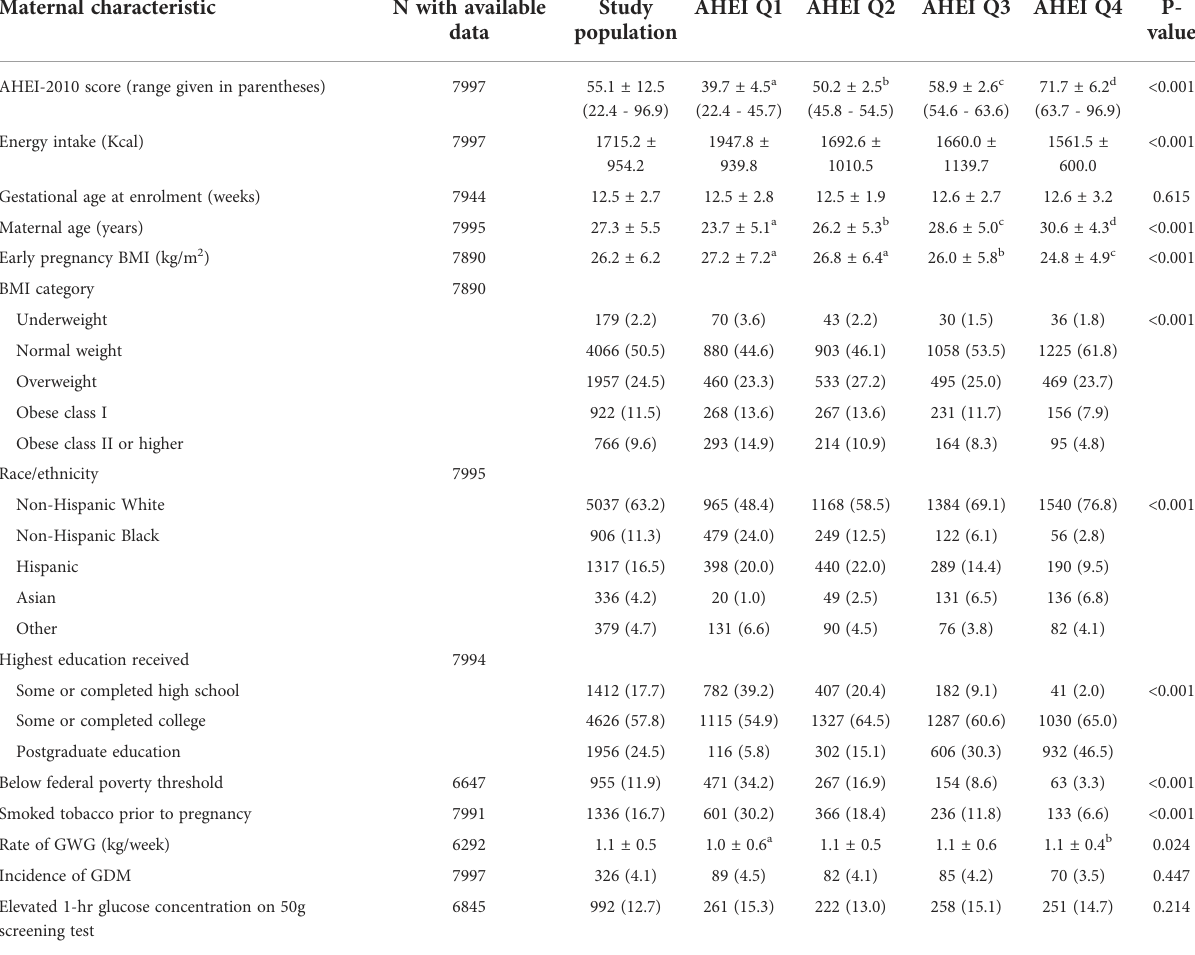
TABLE 1 Descriptive statistics of study population strati fi ed by periconceptional diet quality. Maternal characteristic N with